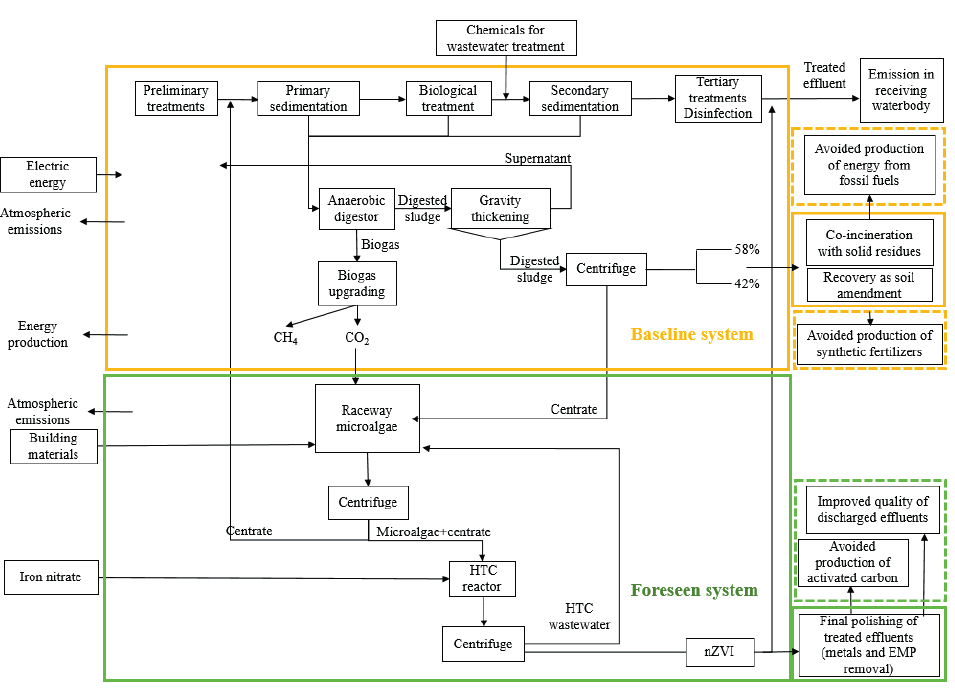
Fig. 1. Layout of the LCA’s system